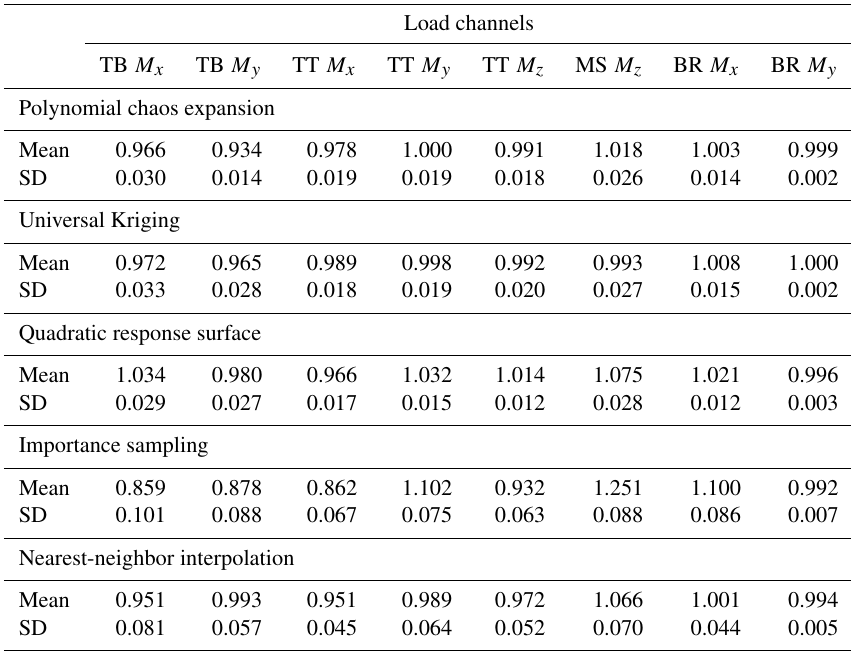
Table 7. Lifetime-equivalent load predictions normalized with respect to MC simulations and averaged over 10 reference sites. Load channel abbreviations are the following: TB: tower base; TT: tower top; MS: main shaft; BR: blade root. Loading directions consist of M x : fore-aft (flapwise) bending; M y : side-side (edgewise) bending; and M z : torsion.